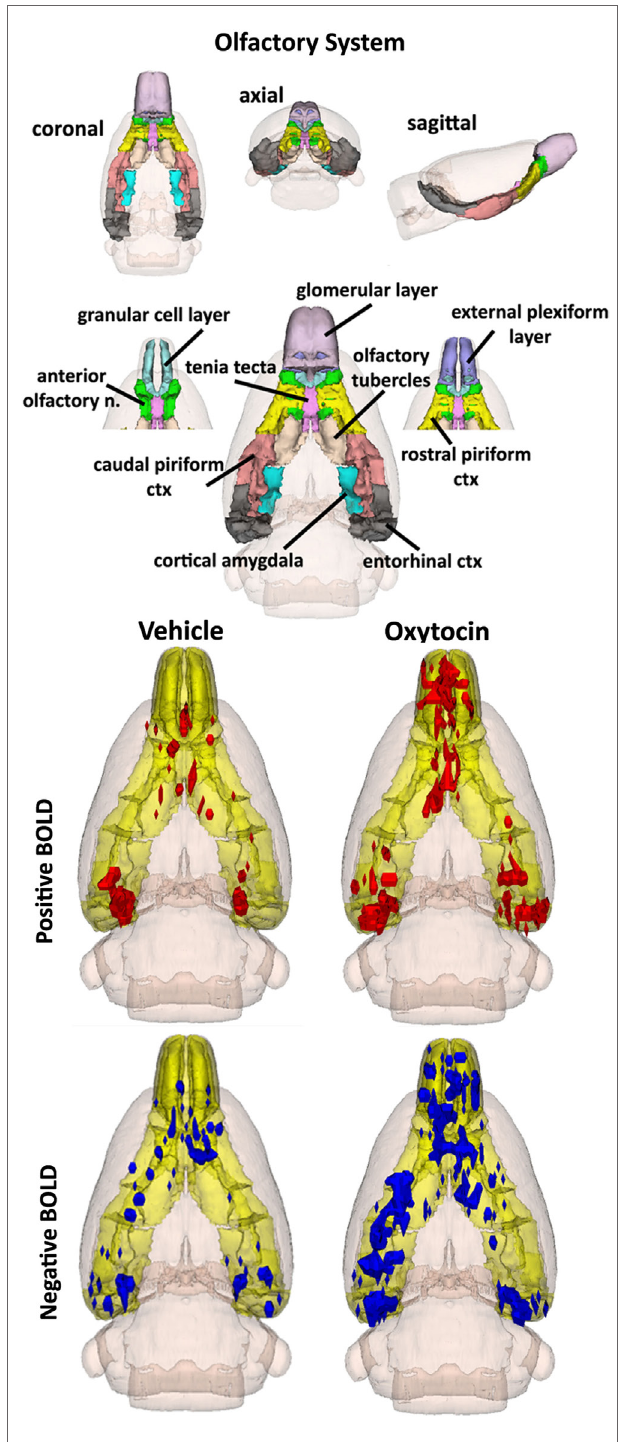
FigUre 4 | The 3D color model at the top depicts the location of the brains that comprise the primary olfactory system in the rat . These areas have been coalesced into a single volume (yellow) as shown in the lower 3D images for intraperitoneal OT ( n = 12) and vehicle ( n = 12). Areas in red (positive BOLD) and blue (negative BOLD) are the localization of the significantly changed voxels comprising the composite average from the rats in each experimental group.